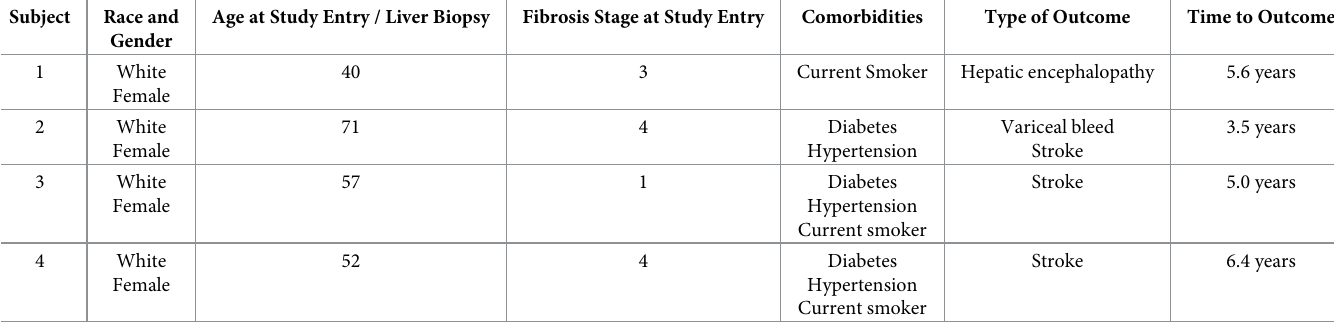
Table 2. Characteristics of patients who experienced liver or cardiovascular related events during follow